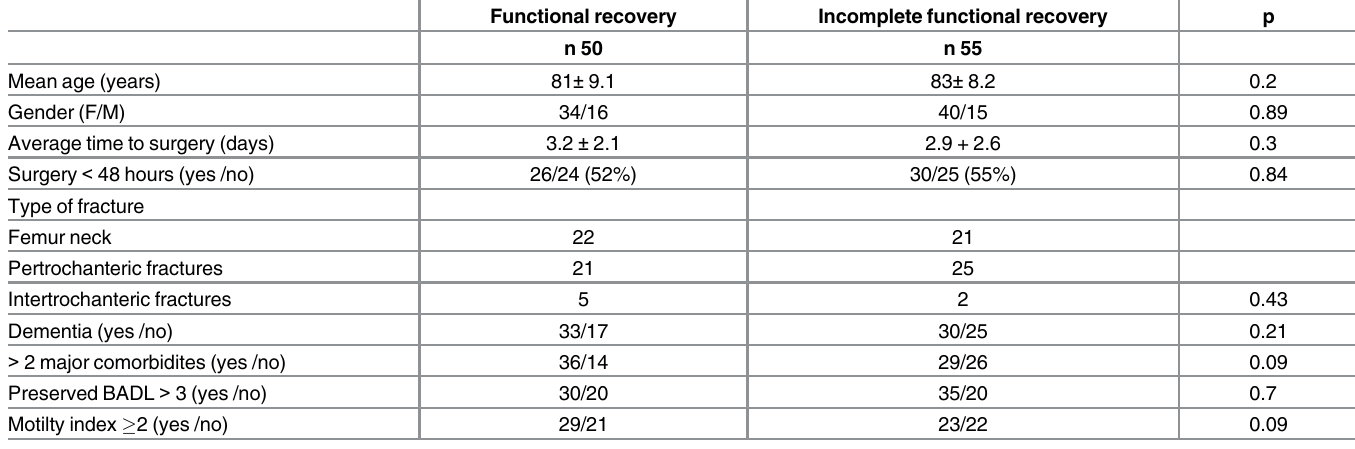
Table 5. Univariate analysis of factors related to 3-month functional